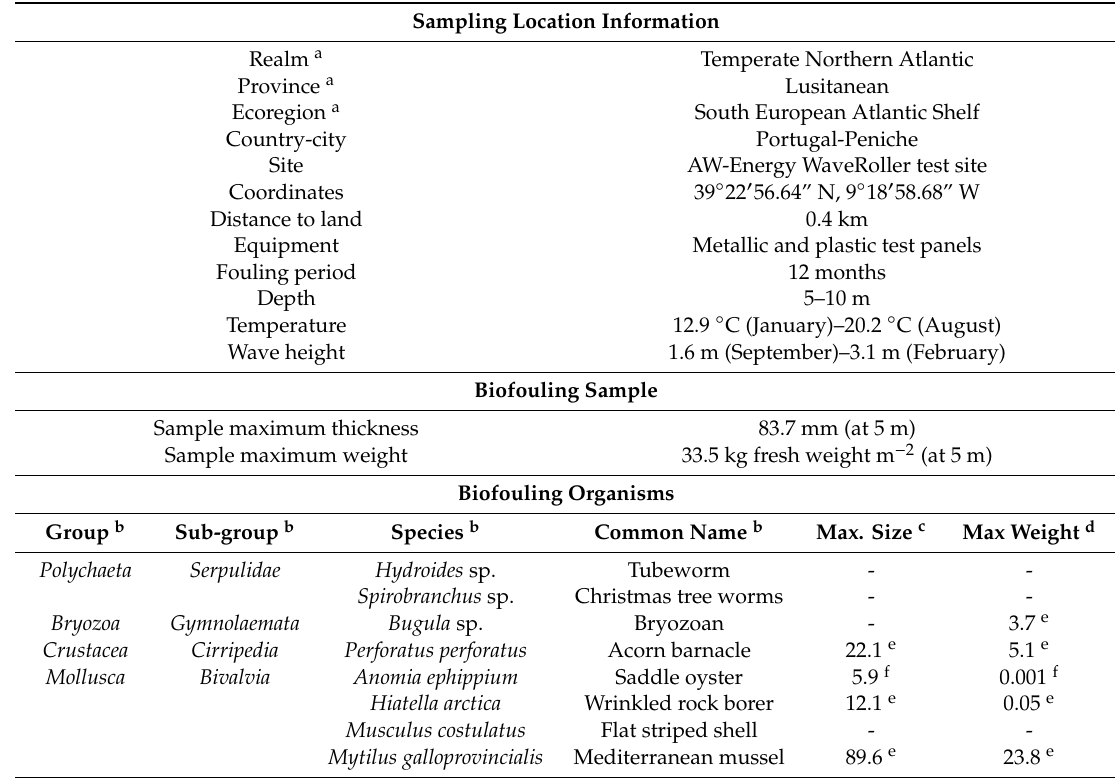
Table 4. Example of the European biofouling database